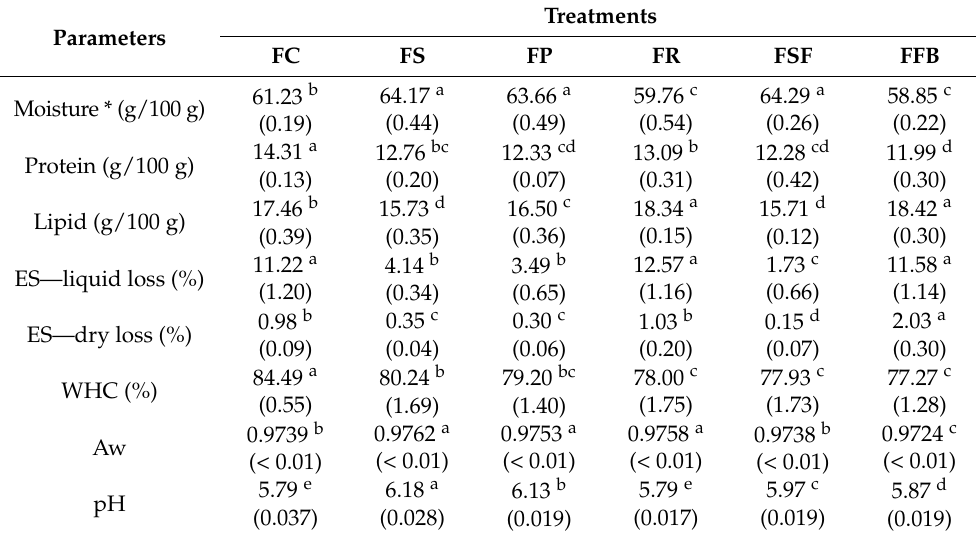
Table 3. Mean values ( ± standard deviation) of physicochemical parameters of hybrid meat emulsions with plant